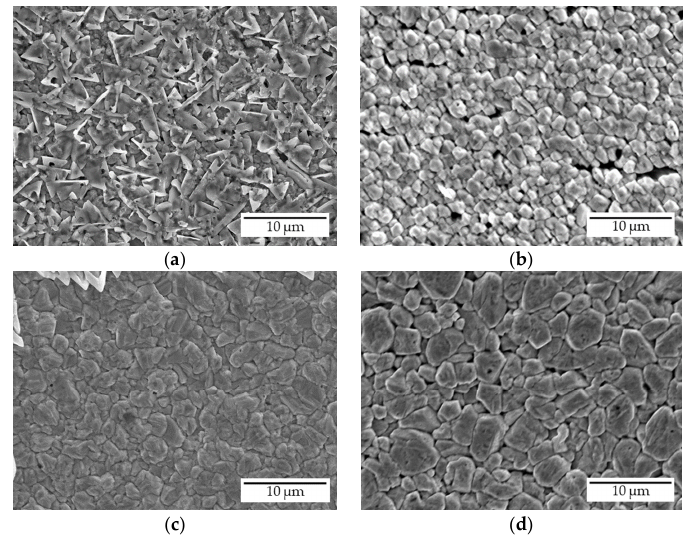
Figure 7. Surface SEM images of composite coatings deposited at an amount of electricity of ( a ) 10 C, ( b ) 20 C, ( c ) 50 C, and ( d ) 100 C.